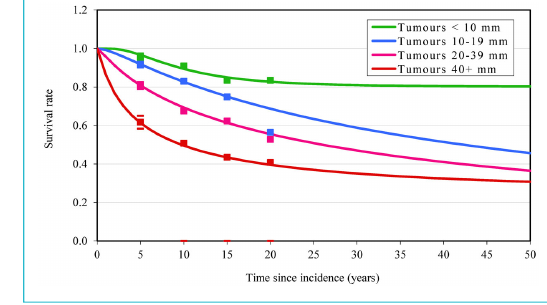
Figure 2: Survival by tumour size, observations (with 95% confi- dence intervals assuming binomial distributions), and fitted lognor- mal curves.